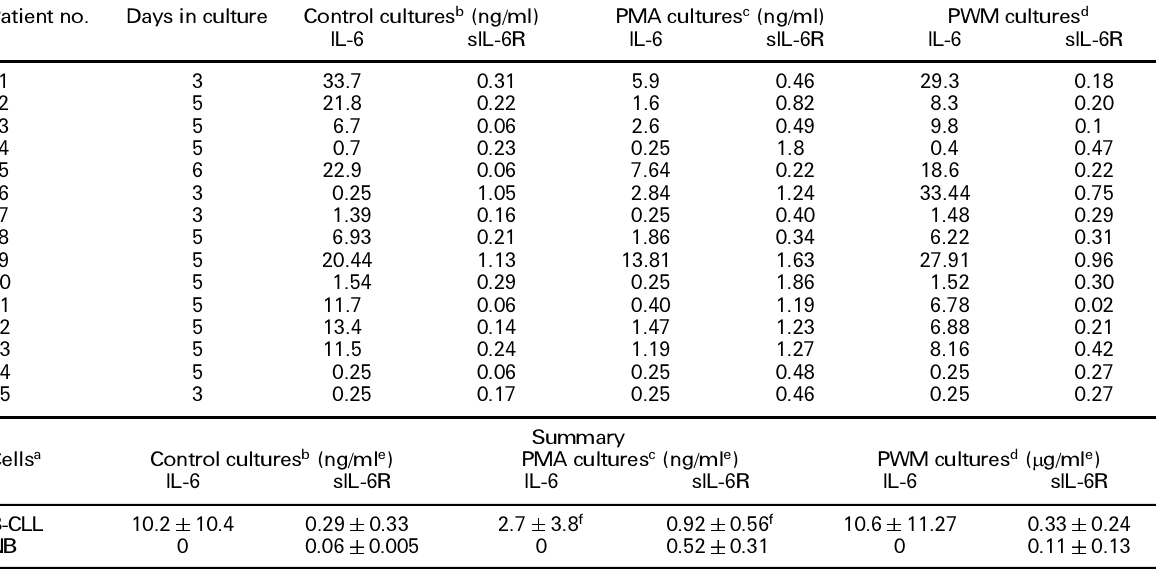
Table 1. IL-6 and sIL-6R levels in supernatants of cultures of B-CLL B lymphocytes a